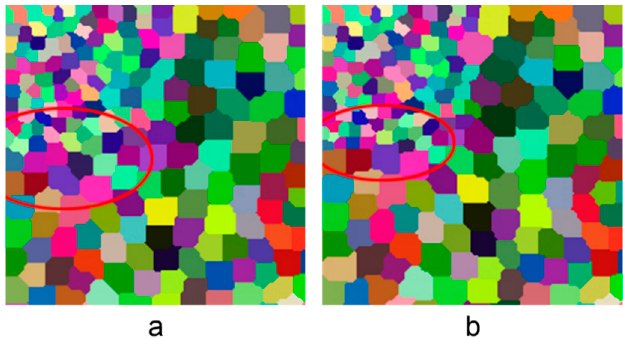
Figure 10. Circular cones with different slopes.